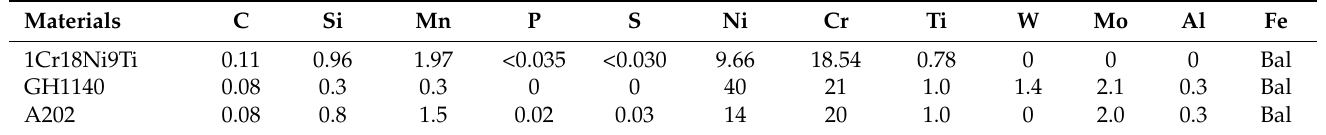
Figure 1. ( a ) TIG welding diagram of 1Cr18Ni9Ti/GH1140 dissimilar material flat plate; ( b ) dimensional diagram of the high-cycle tension–tension fatigue specimen wire cut from the 1Cr18Ni9Ti/GH1140 dissimilar-material welded flat pieces in Figure ( a ); ( c ) laser shock peening area and its shock path for the tension–tension fatigue specimen in Figure ( b ); ( d ) welded joint diagram of combustion liner components; ( e ) sheet weld specimen cut off from Figure ( d ) and laser shock peening area and its shock path diagram. Table 1. Chemical compositions of 1Cr18Ni9Ti stainless steel and GH1140 Ni-based superalloy (wt.%).